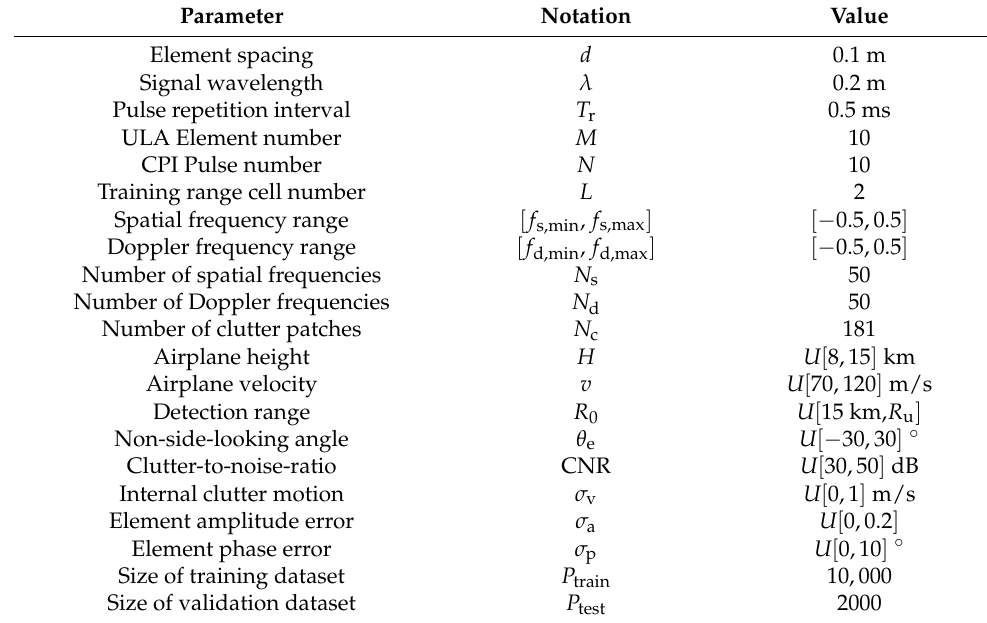
Table 1. Simulation